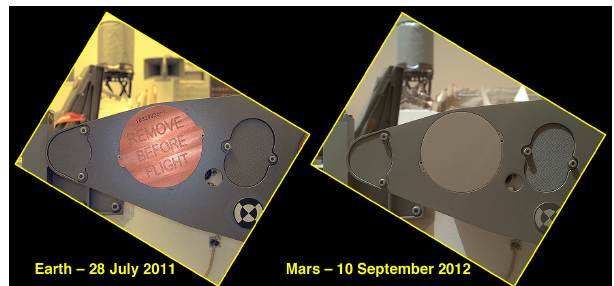
Figure 8. Example of MSL MAHLI imaging support for robotic arm teach point establishment. The front end of the Organic Check Material-1 canister (OCM-1; circular feature) diameter is 6.25cm (Conrad et al., 2012). During the second phase of rover com- missioning (sols 32–37; 8–13 September 2012), MAHLI was em- ployed to image (1) portions of the rover to record their post- landing status, and (2) pre-launch-designated arm and turret po- sitions (teach points) at rover hardware positions that were ex- pected to be imaged repeatedly over the course of the mission. These included two of the five OCMs (1 and 5; Conrad et al., 2012), one of two replacement drill bit boxes (Anderson et al., 2012), and the observation tray (Anderson et al., 2012, Berger et al., 2014). In this example, OCM-1 was imaged before launch in July 2011 (left; image ATL_MH0090060020001340E01, illuminated by artificial overhead lighting and MAHLI’s white light LEDs) and then imaged again on Mars in September 2012 (right; image 0034MH0000410010100009C00, illuminated by sunlight from the top left).